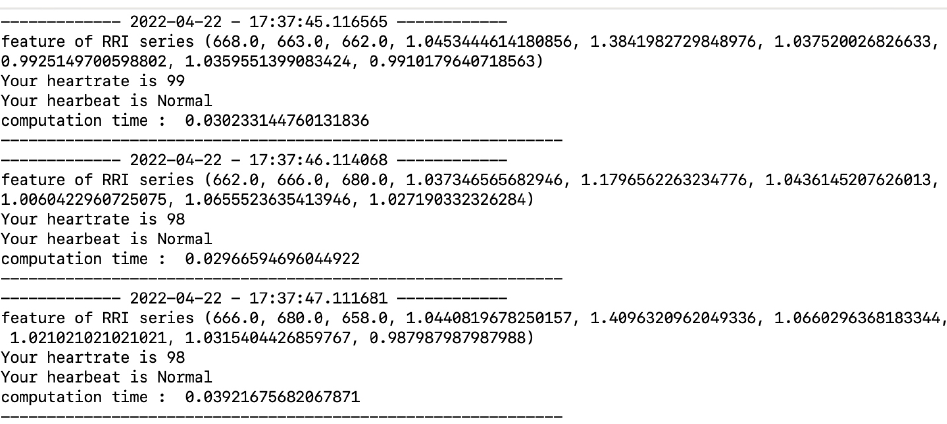
Figure 4. An output of real-time prediction of